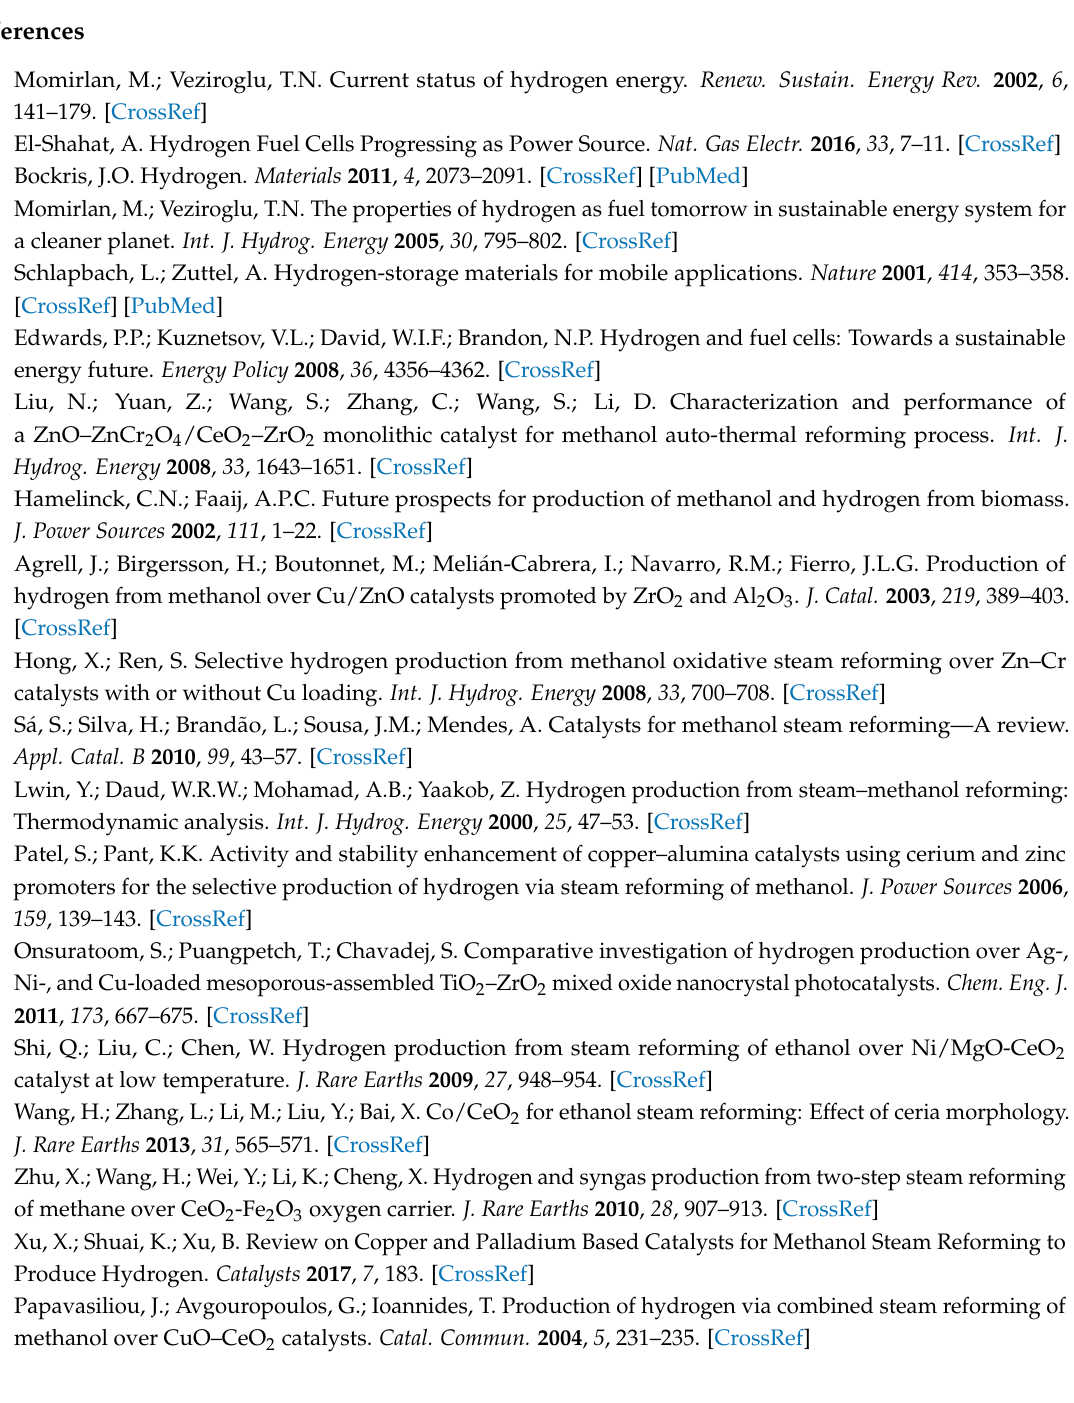
Figure S1: The XPS Au(4f) of